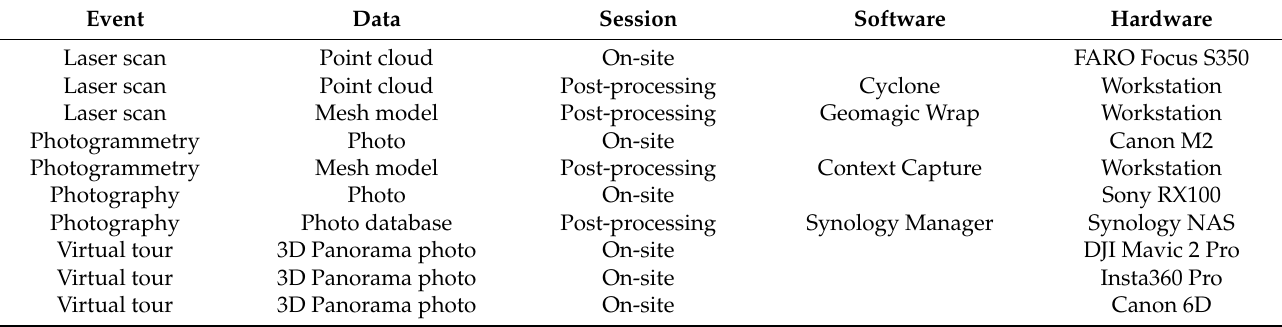
Figure 13. The rebuild workflow of HBIM. Table 2. The survey event log by